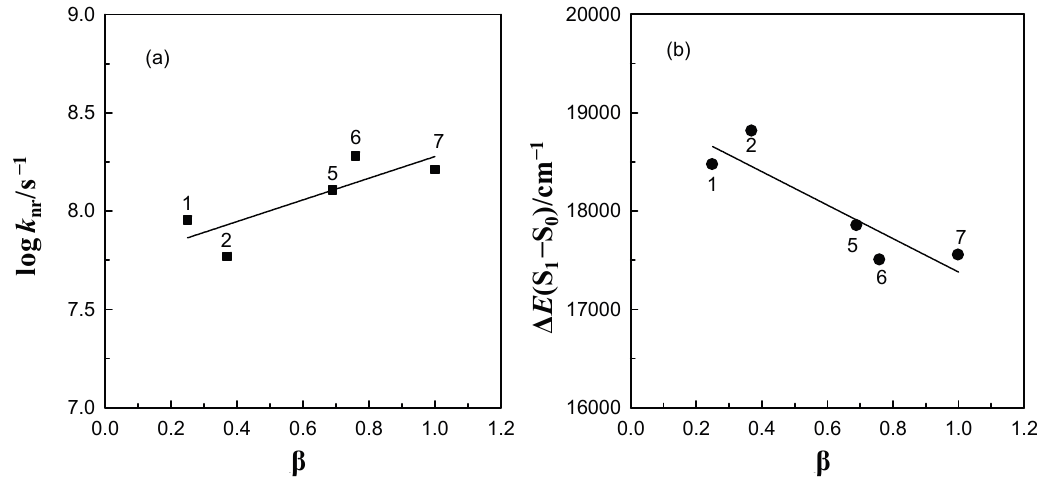
Figure 7. Correlation between the logarithm of the nonradiative deactivation rate constant, log k nr , ( a ) and the ∆ E (S 1 –S 0 ) = ν (cid:2890)(cid:2923)(cid:2911)(cid:2934) energy gap ( b ) of 6AC-(solvent) n , n = 1, 2, S 1 -excited complexes in acrylonitrile (1), propionitrile (2), DMF, (5), DMSO (6), HMPA (7) and the solvent Kamlet-Taft’s hydrogen-bonding acceptor